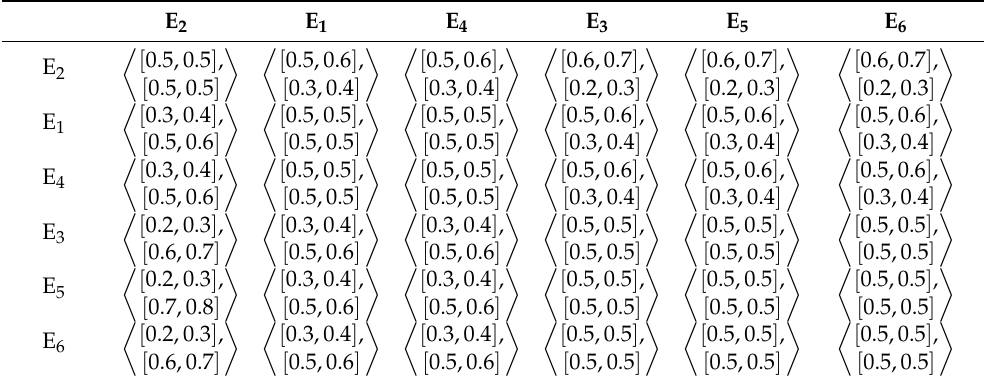
Table 12. Aggregated decision interval matrix in IVPF–AHP for the sub-criteria E (CI = 0.0116255, CR = 0.00937541).